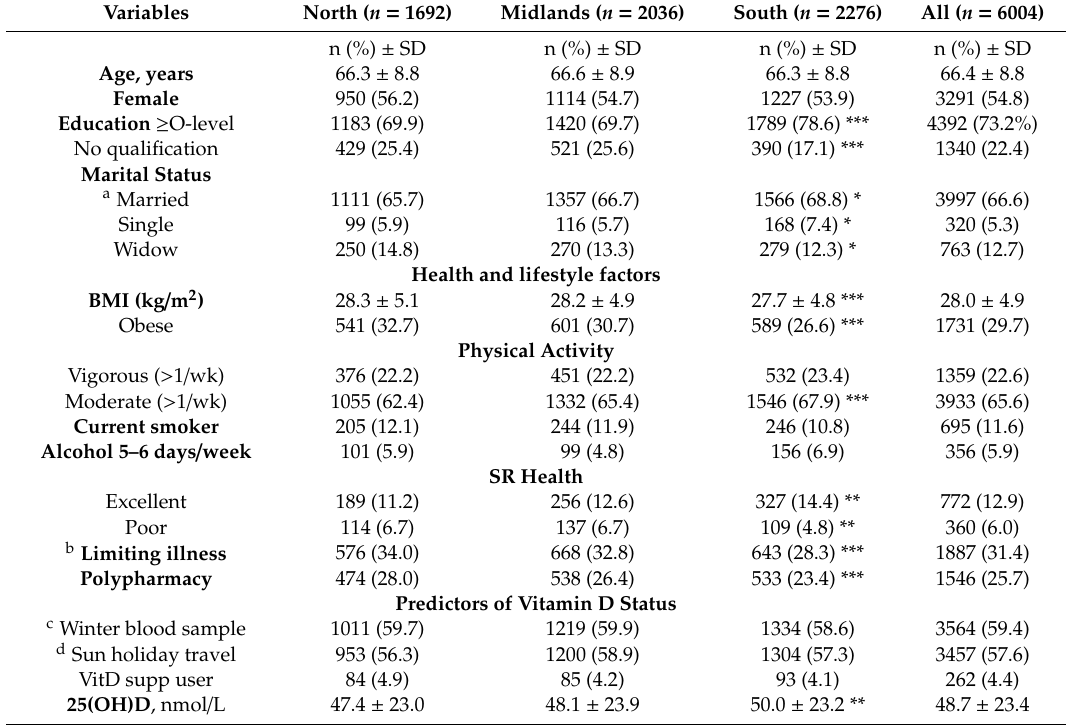
Table 1. Participant characteristics stratified by region of residence in England ( n =